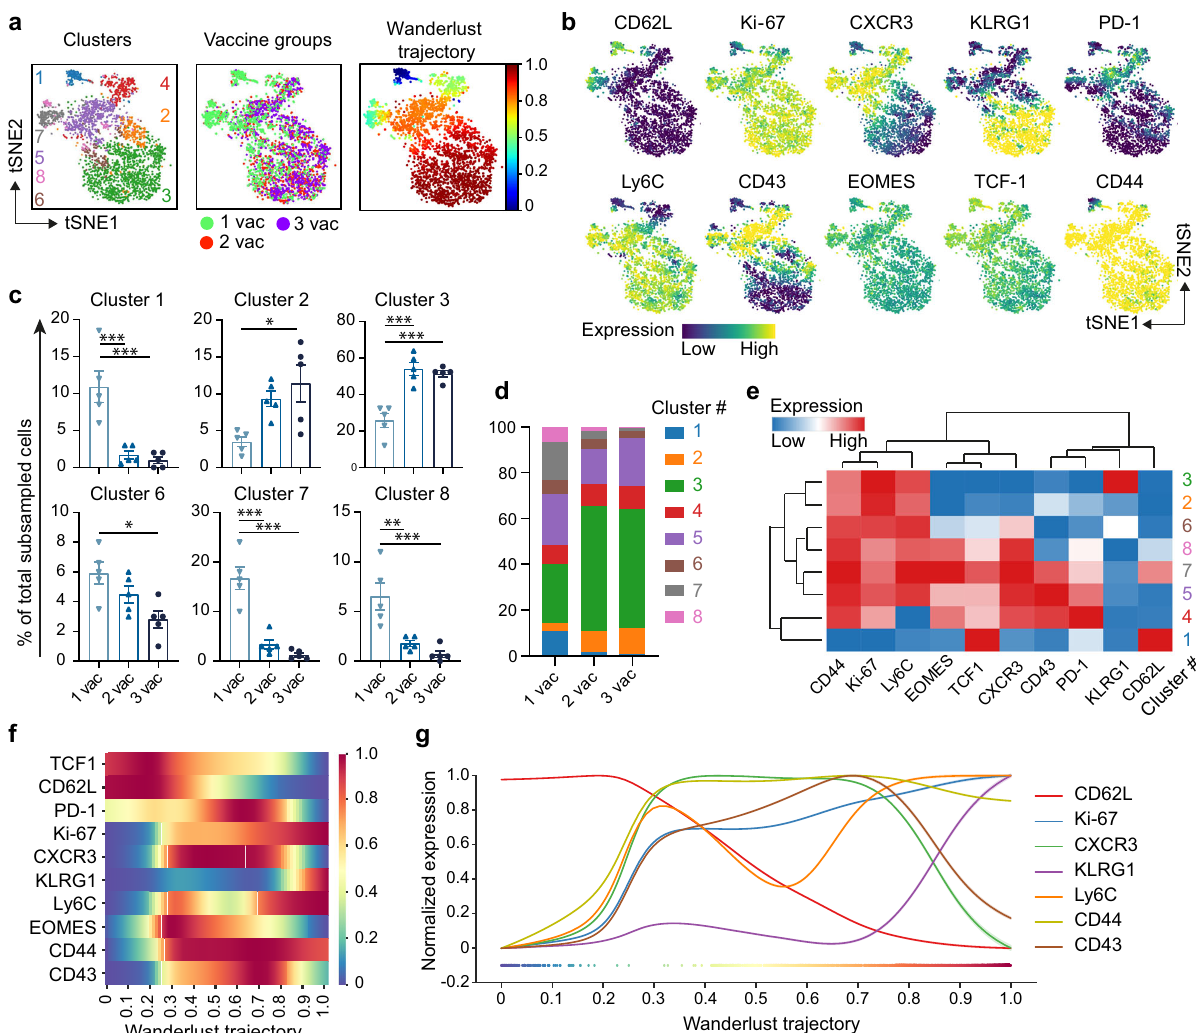
Fig. 4 Progressive differentiation of vaccine-speci fi c CD8 + T cells after booster vaccination. C57BL/6 mice were vaccinated subcutaneously on day 0 (1 st vaccination), day 14 (2 nd vaccination), and day 28 (3 rd vaccination) with the Spike 539-546 -SLP vaccine adjuvanted with CpG. a Following tSNE analysis downsampling, FlowSOM consensus metaclustering with 8 clusters as well as Wanderlust trajectory analysis was performed on 200 live CD3 + CD8 + CD4 − CD19 − Spike 539-546 tetramer + cells harvested from the spleen at day 69 after SLP vaccination. Overlay of the 8 FlowSOM clusters (left), vaccination status (middle) and Wanderlust trajectory (right) (color indication: blue, beginning/early; red, end/late) on the tSNE-map. b Expression intensity of cell surface markers (color indication: blue, low expression; yellow, high expression). c Signi fi cant clusters were selected and are shown in bar graphs. Data represented as mean ± SEM ( n = 5 per group). Symbols represent individual mice. * P = 0.011 – 0.015, ** P = 0.0043, *** P = 0.001 – 0.009, **** P = <0.0001. d Stacked bar graph of all 8 FlowSOM clusters per vaccination group, colors match ( a ). e Hierarchically clustered heatmap of phenotypes of the clusters shown in ( a ) — the indicated marker expression is shown per cluster as z-Score of median signal intensity per channel; blue, low expression; red, high expression. f Each of the markers used for embedding in fi gure ( a – c ) are displayed according to Wanderlust trajectory progression. g Selected markers are displayed according to Wanderlust trajectory progression. One-way ANOVA with Tukey ’ s multiple comparison test for ( c ). Source data are provided as a Source Data fi